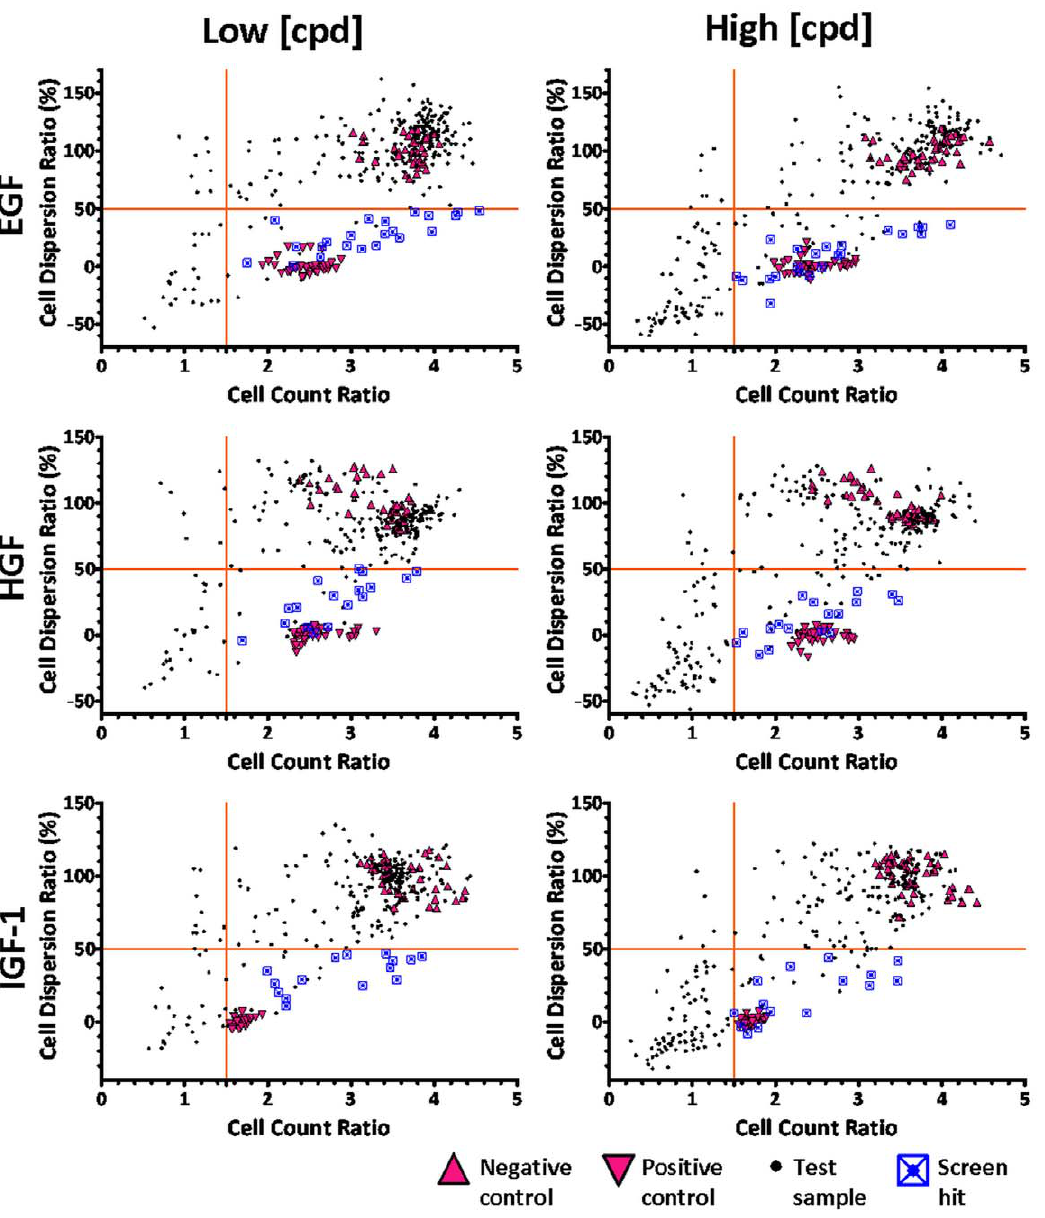
Figure 3. Cell dispersion ratio (CDR) vs. cell count ratio (CCR) plots. The graphs illustrate the behavior of NBT-II cells treated with different test compounds and growth factors in the spot migration assay. CDR threshold was set at 50% CDR between positive control CDR and negative control CDR. CCR threshold was set at 1.5 growth rate. We assessed compounds that inhibit cell dispersion (i.e. less than CDR threshold) and do not severely inhibit cell growth (i.e. more than CCR threshold). To further refine our hits, the test compounds were run at a low and high concentration (1.67 and 6.67 m M, respectively). Hit compounds (crossed squares) were classified as test compounds that satisfy the CDR and CCR threshold criteria at both